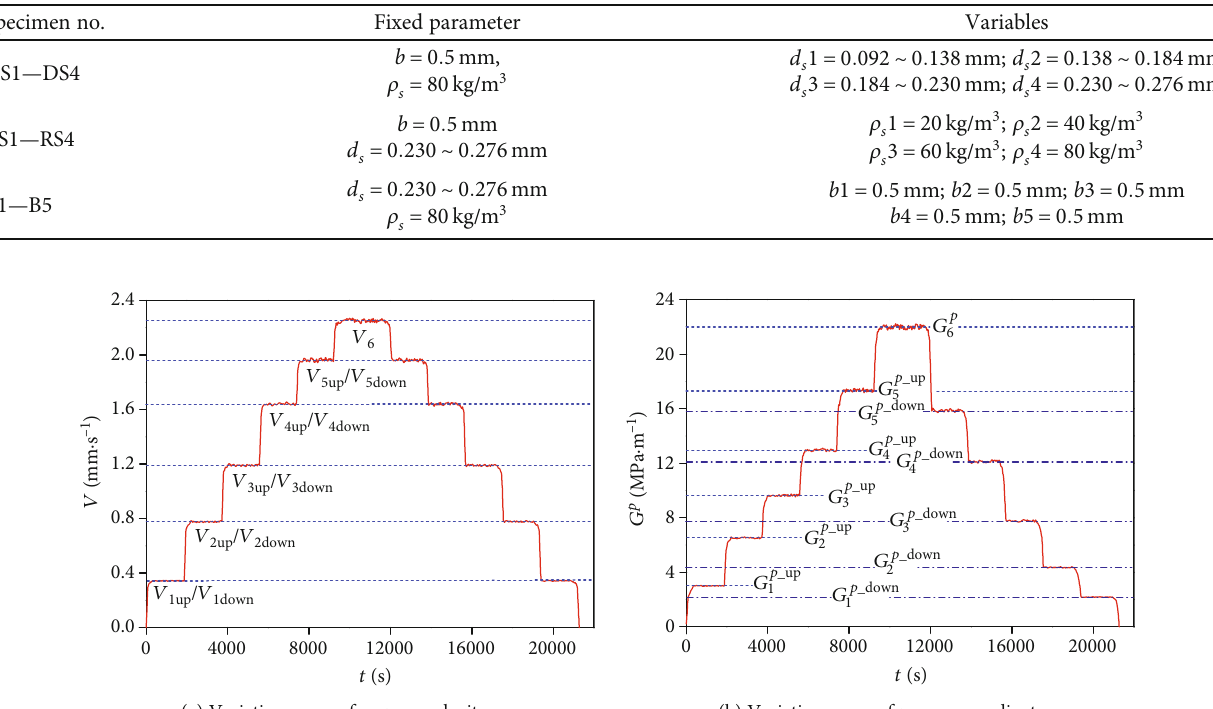
(b) Variation curve of pressure gradient Figure 9: Variation curve of seepage parameters with